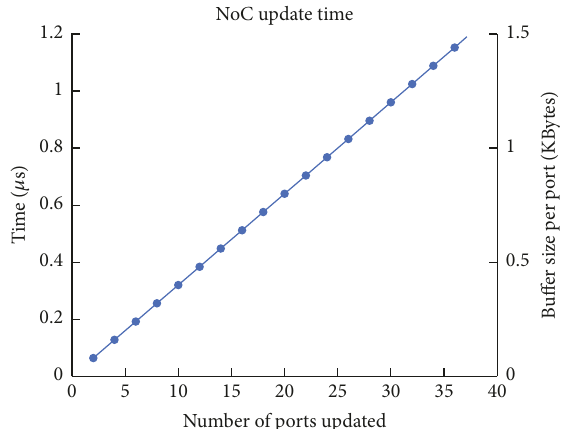
Figure 10: Time and buffer needed for packet loss free NoC update